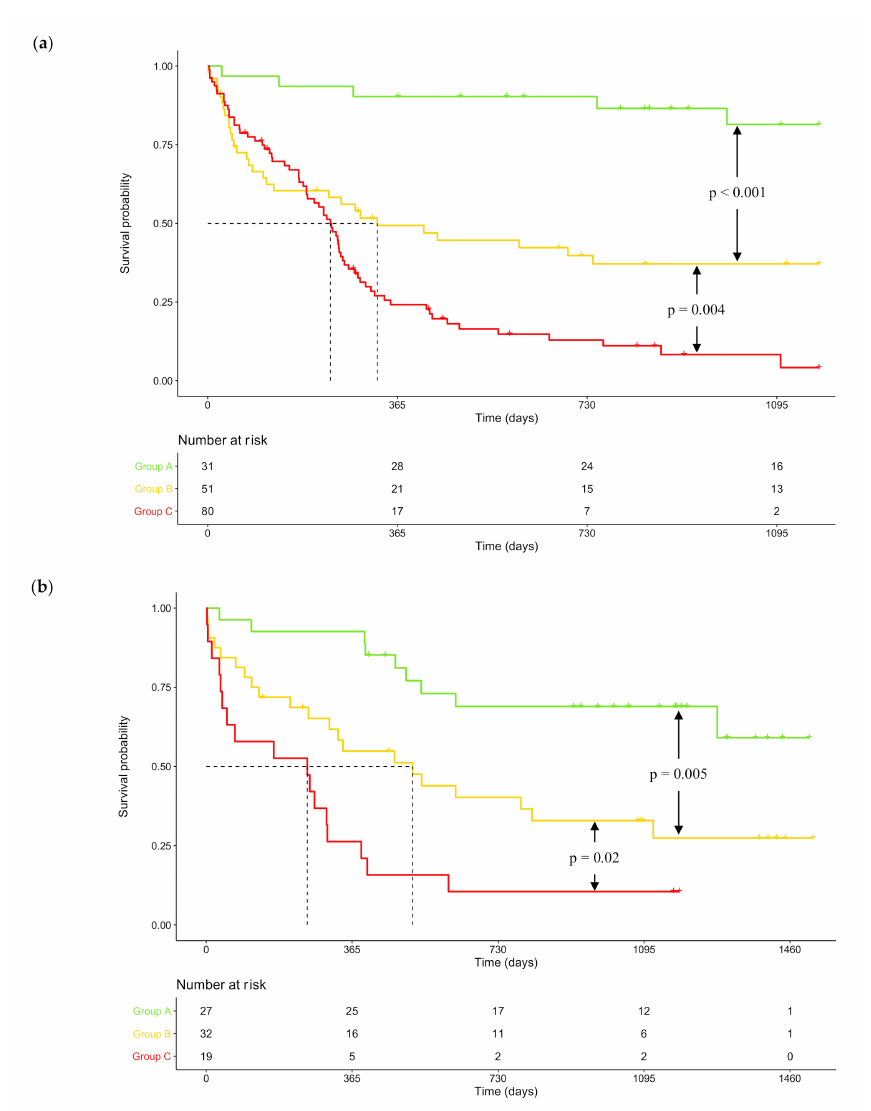
Figure 3. Kaplan–Meier survival curves according to risk groups determined by combined score incorporating DNA repair score and NPM1 / FLT3 mutational status. ( a ) Kaplan–Meier survival curve in the training cohort ( n = 162). Median OS was not reached (95% CI: NR-NR), 326 days (95% CI: 127–NR) and 236 days (95% CI: 190–263) respectively for patients in groups A, B and C. One-year OS was 90.3% (95% CI: 80.5–100) in group A, 49.3% (95% CI: 37.1–65.7) in group B, and 24.2% (95% CI: 16.2–36.2) in group C. ( b ) Kaplan–Meier survival curve in the validation cohort ( n = 78). Median OS was not reached (95% CI: 1278-NR), 516 days (95% CI: 308-NR) and 253 days (95% CI: 52–403) respectively for patients in groups A, B and C. One-year OS was 92.6% (95% CI: 83.2–100) in group A, 54.9% (95% CI: 39.8–75.7) in group B, and 26.5% (95% CI: 12.4–55.8) in group C. p -values were determined with the log-rank test. NR: not